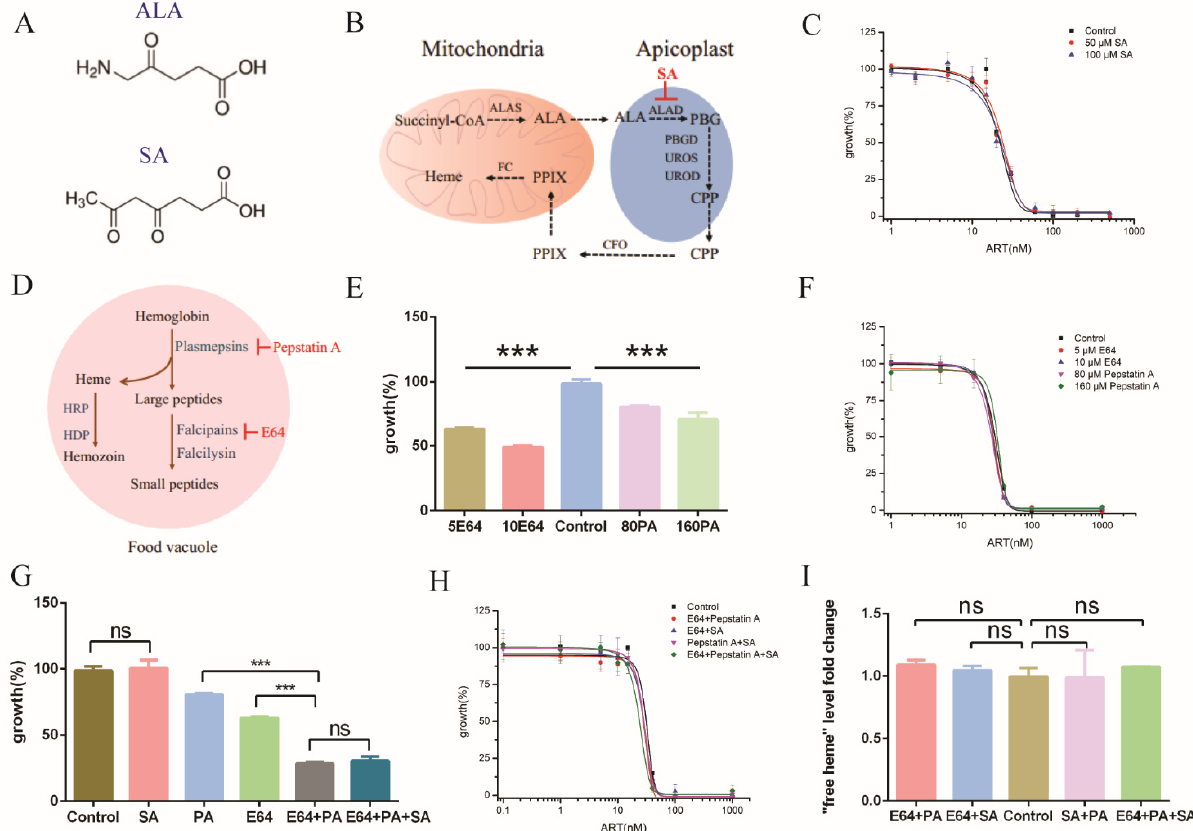
Figure 5. Inhibiting heme biosynthesis and/or hemoglobin degradation had little effect on the effect of artemisinin. ( A ) Chemical structure of ALA and SA. ( B ) Heme de novo biosynthesis pathway in Plasmodium falciparum. ( C ) EC 50 of artemisinin in P. falciparum was not changed by the addition of SA. ( D ) Hemoglobin degradation and hemozoin formation pathway in P. falciparum. ( E ) Amounts